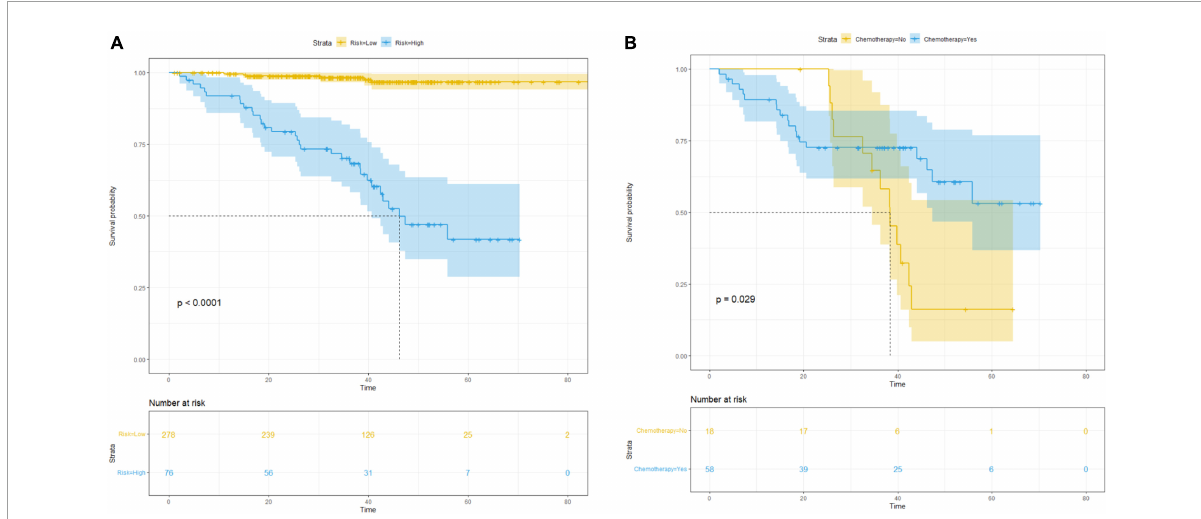
FIGURE4 Survival curves for subgroup analysis in patients with different risk of postsurgical recurrence stratified by nomogram score. (A) Kaplan–Meier survival curves for RFS according to the risk status in all patients; (B) RFS according to different therapy in high-risk